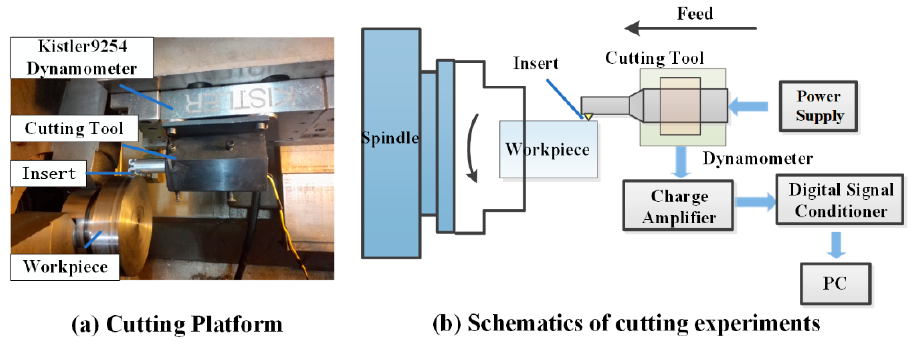
Figure 4. Experiment platform.